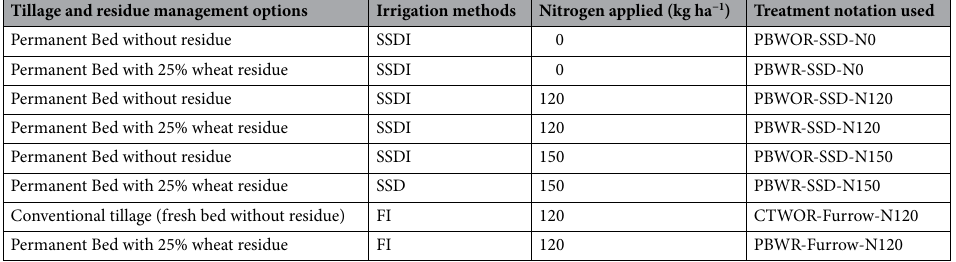
Table 4. Treatment details and notation used in the study. SSDI: subsurface drip irrigation; FI: furrow irrigation.